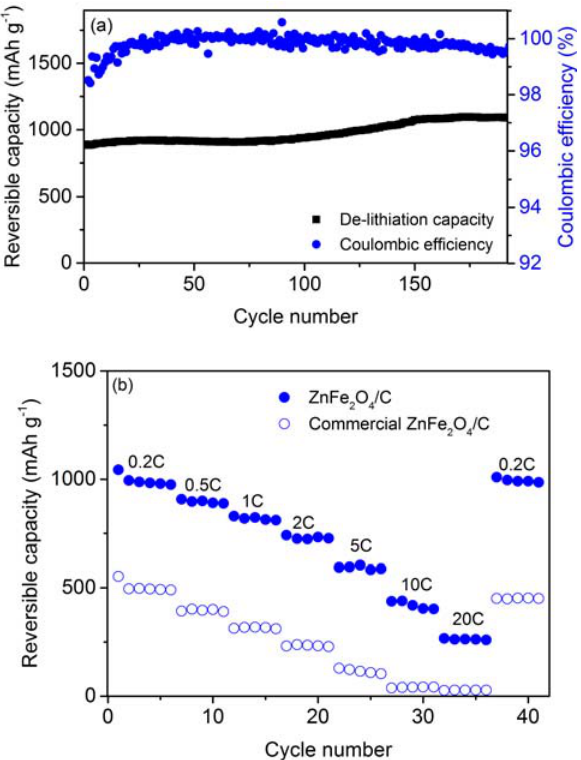
Figure 9. a) De-lithiation capacity curves and coulombic efficiency curves of the constant current cycling of ZnFe cle) and 0.5C (following cycles); b) Reversible capacity curves of ZnFe O /C at different specific currents (C-rate investigation). Cut- 2 4 off voltages for a) and b): 0.01 V and 3.0